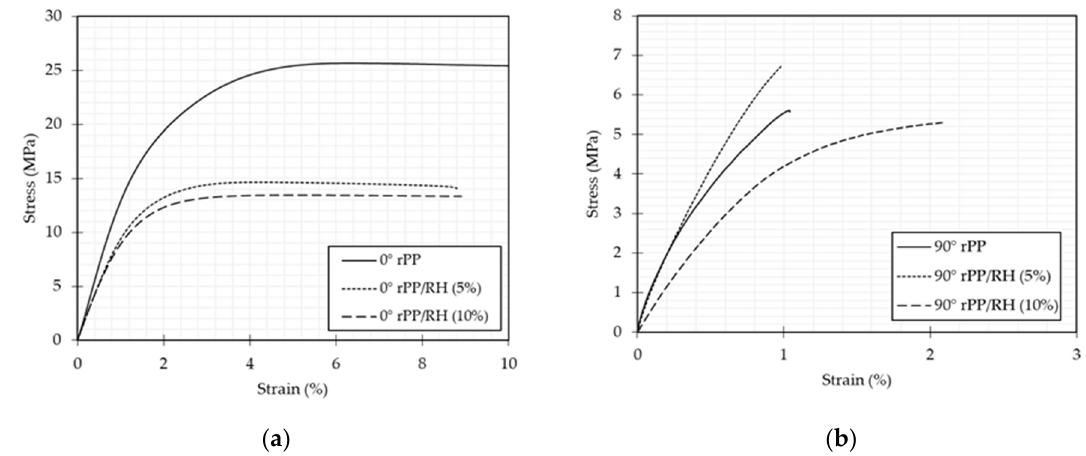
Figure 6. Stress-strain curve for rPP and rPP/RH (5 and 10 wt.%) composites ( a ) printed at 0° and ( b ) printed at 90°.